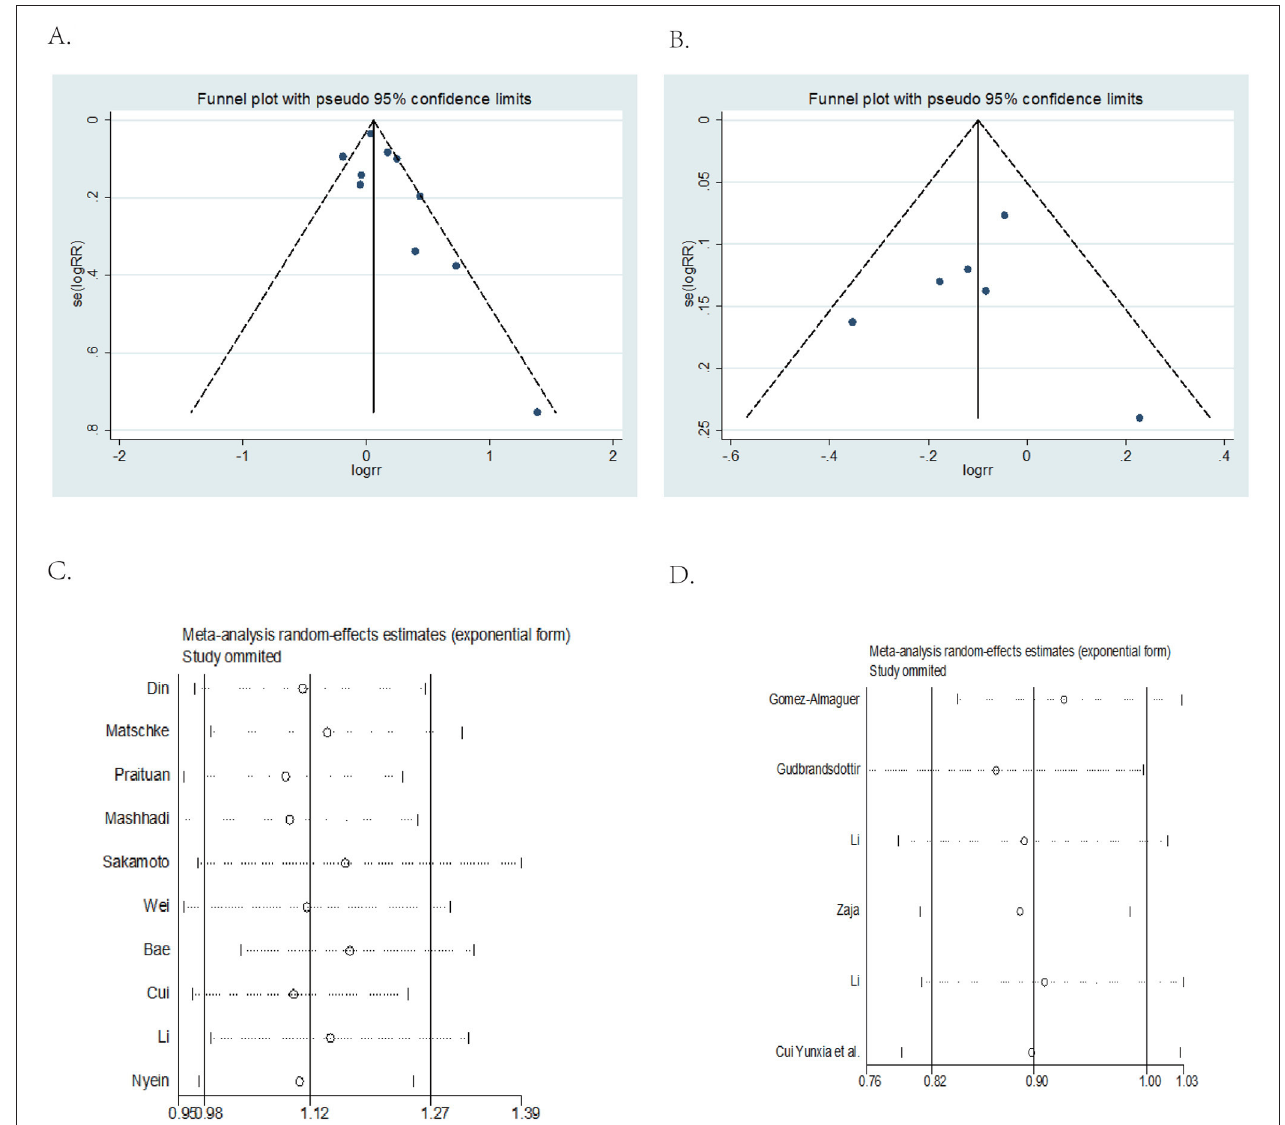
FIGURE 3 | Funnel plot and Egger’s test and sensitivity analysis. (A) DXM vs. PNS Funnel plot and Egger’s test. (B) DXM vs. RTX + DXM Funnel plot and Egger’s test. (C) DXM vs. PNS sensitivity analysis. (D) DXM vs. RTX + DXM sensitivity analysis.